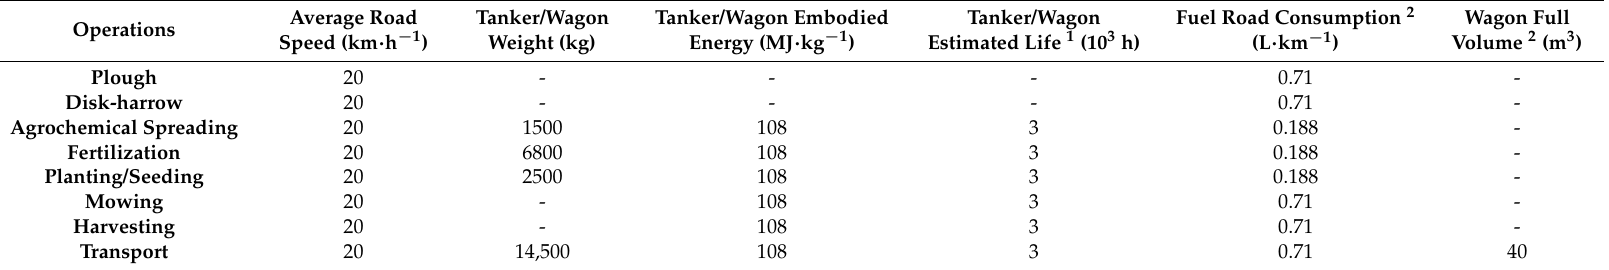
Table 3. Transportation Inputs.